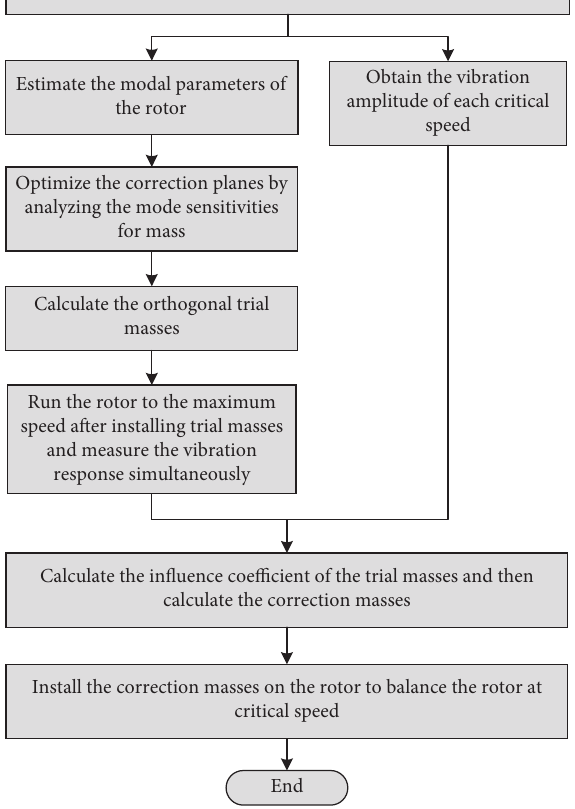
Figure 1: The schematic illustration of the